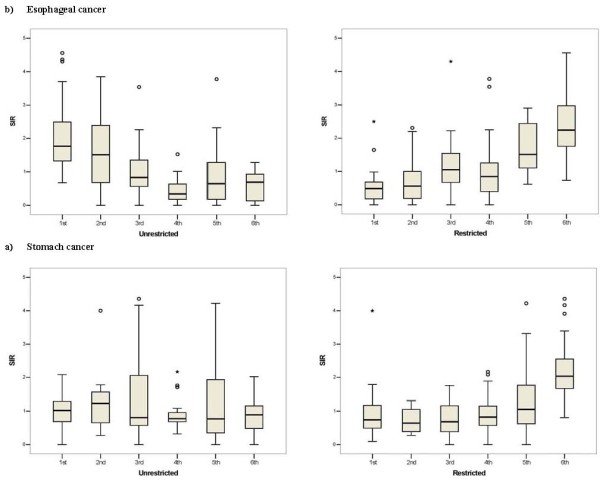
Relationship between esophageal (a) and gastric (b) cancer SIRs, and sextiles of the following two dietary pattern score factors: unrestricted food choice, and restricted food choice. Each boxplot within each panel displays the distribution of the SIRs within that sextile.